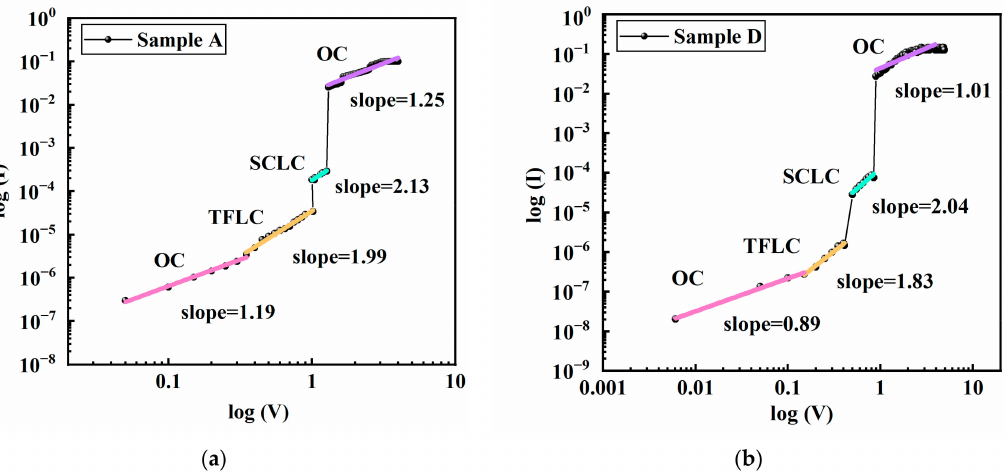
Figure 7. ( a ) The linear fitting curve of the device ITO/PIB/Al. ( b ) The linear fitting curve of the device ITO/PIB: SnO 2